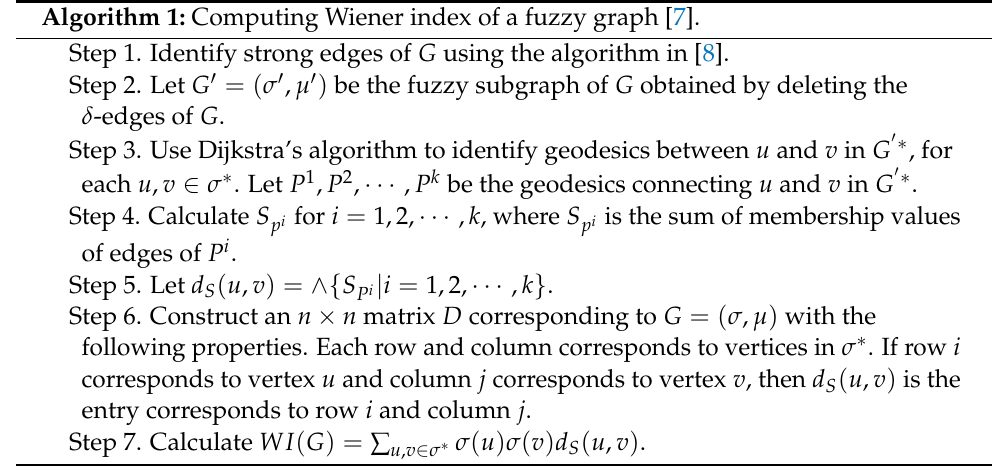
Algorithm 1: Computing Wiener index of a fuzzy graph